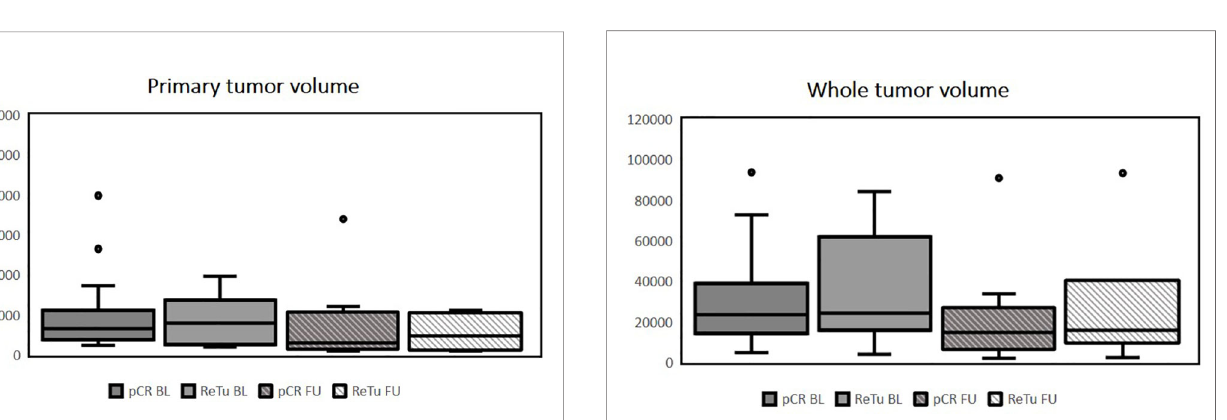
FIGURE 1 | Tumor volume of the primary tumor in mm 3 , outliers are marked with dots, no signi fi cant differences among groups at baseline or follow-up were present using the Kruskal-Wallis test (pCR BL, pathologic complete response at baseline; ReTu BL, residual tumor at baseline; pCR FU, pathologic complete response at follow up; ReTu FU, residual tumor at follow up).